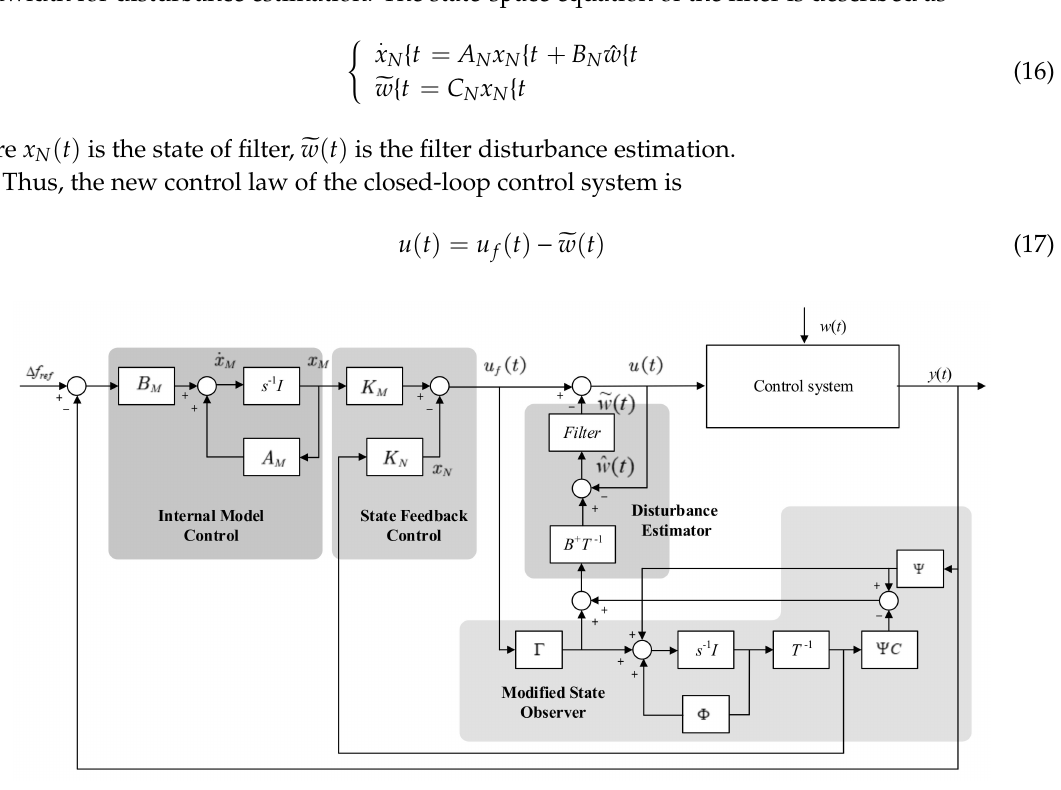
Figure 5. Configuration of the EID-based closed-loop control